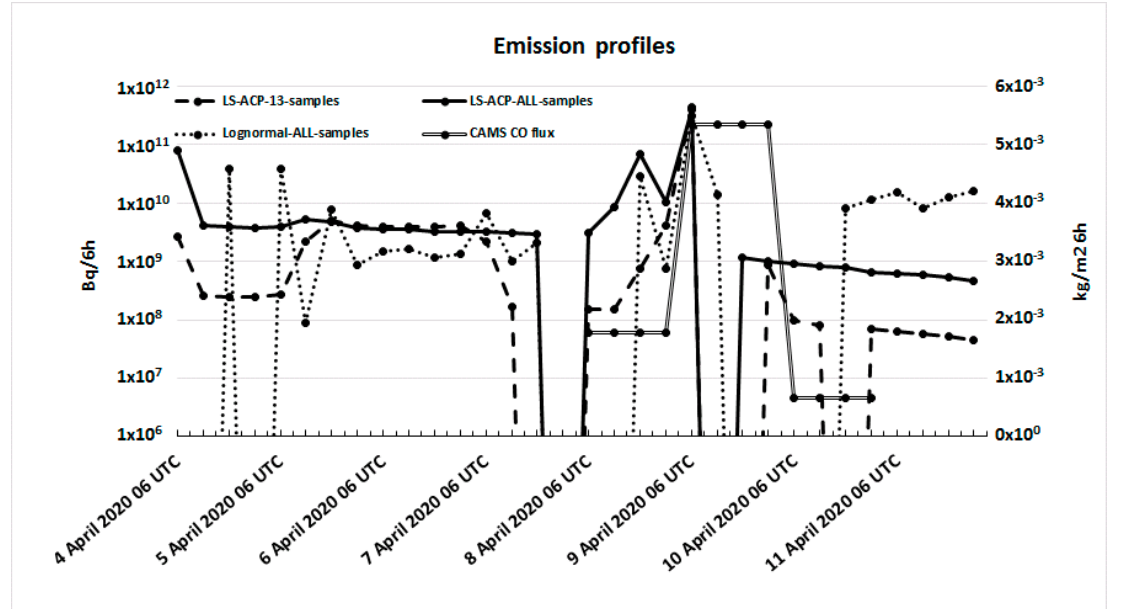
Figure 5. Cs-137 mission profiles (Bq/6h) for the period 4 to 12 April resulting from the LS-APC and the lognormal approaches as well as the CAMS CO emission flux (kg/m 2 6h) for 8 to 11 April. Source location was constraint to 1000–3000 m a.g.l. in the vertical and nine grid cells centered on the fire location according to CAMS. Zero emission values are not shown. Filled circles indicate the released activity, the total flux respectively, at the end of each six-hour period.